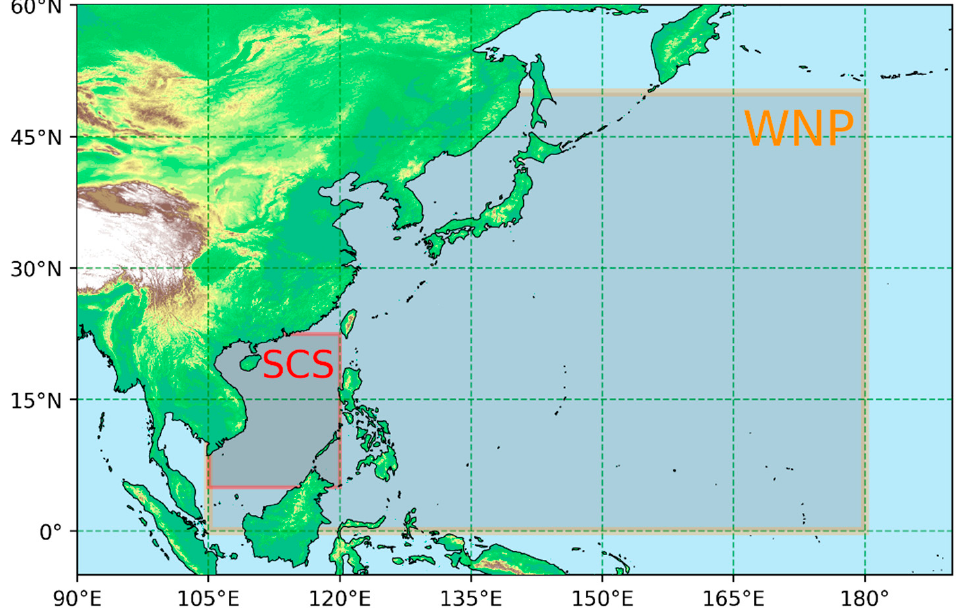
Figure 1. Diagram of the Western North Pacific (WNP) basin (orange box, 0 ◦ –50 ◦ N, 105 ◦ –180 ◦ E) and the South China Sea (SCS) region (red box, 5 ◦ –20 ◦ N, 105 ◦ –120 ◦ E).